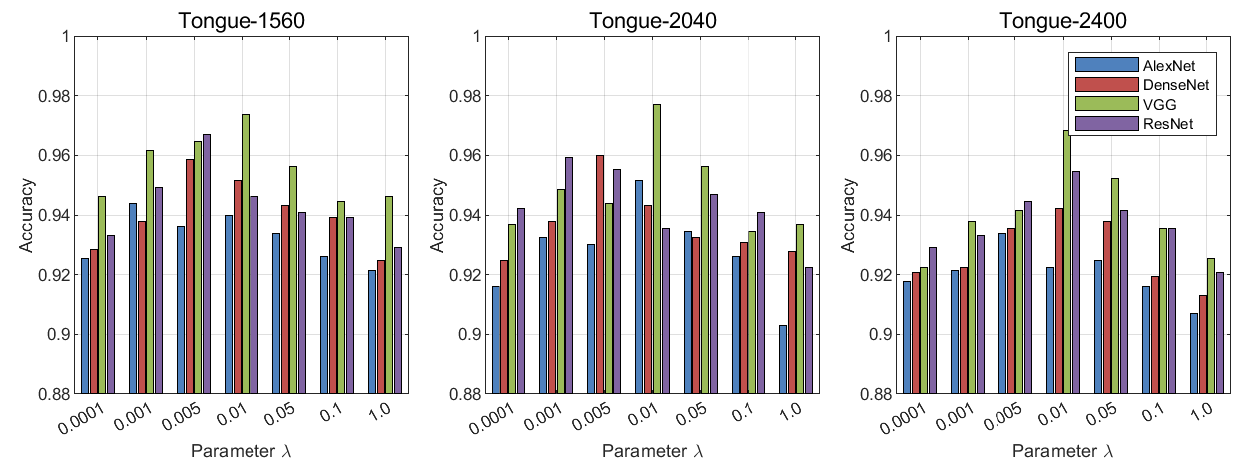
Figure 11. Comparison of mean overall accuracy under different values (RF classifier).